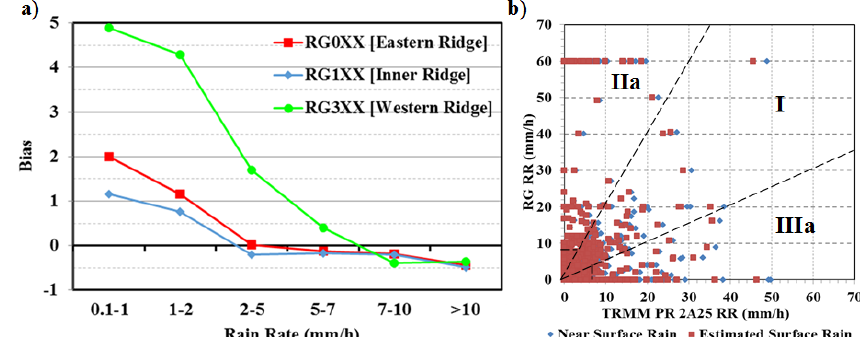
Figure 5. (a) Bias between TRMM 2A25 V7 NSR and average raingauge rain rates for different series: RG0XX, RG1XX, and RG3XX (see Table 1); (b) scatterplot for TRMM 2A25 V7 surface rain rates (NSR and ESR) and average raingauge rain rates during the period 1 June 2008–31 May 2013. Raingauge rain rates are using a 10min (RG0XX and RG1XX) and 30min (RG3XX) scale centered at